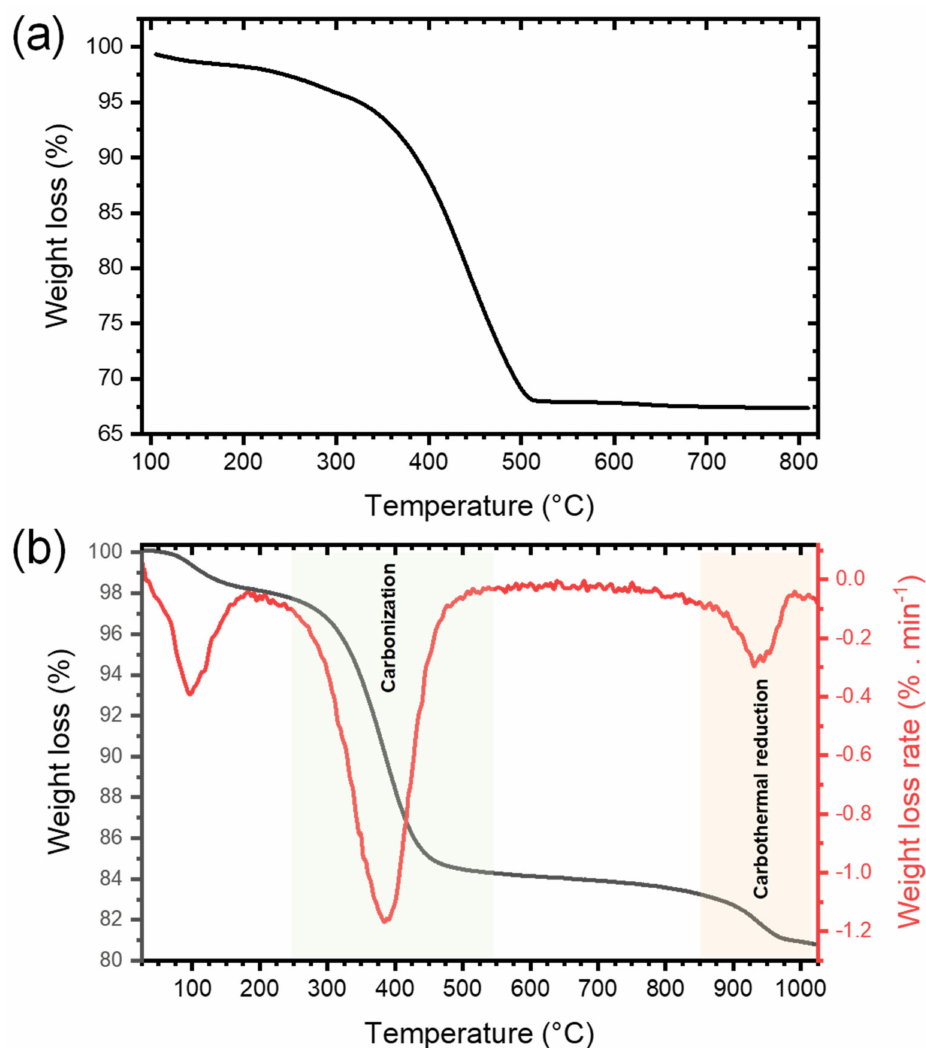
Figure 2. Thermogravimetric analyses performed ( a ) under synthetic dry air flow (50 mL min − 1 ) and ( b ) under argon flow (50 mL min − 1 ) at 10 ◦ C min − 1 of xer-TiO 2